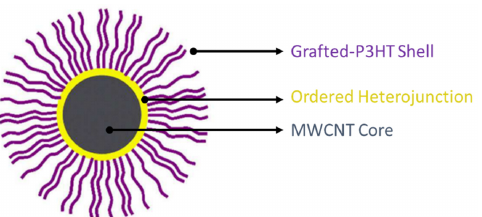
Figure 1. Core-shell structure of multi-walle carbon nanotube-g-poly(3-hexylthiophene) (MWCNT-g-P3HT) nanocomposites prepared by the “grafting-from” method (adapted from [20]).